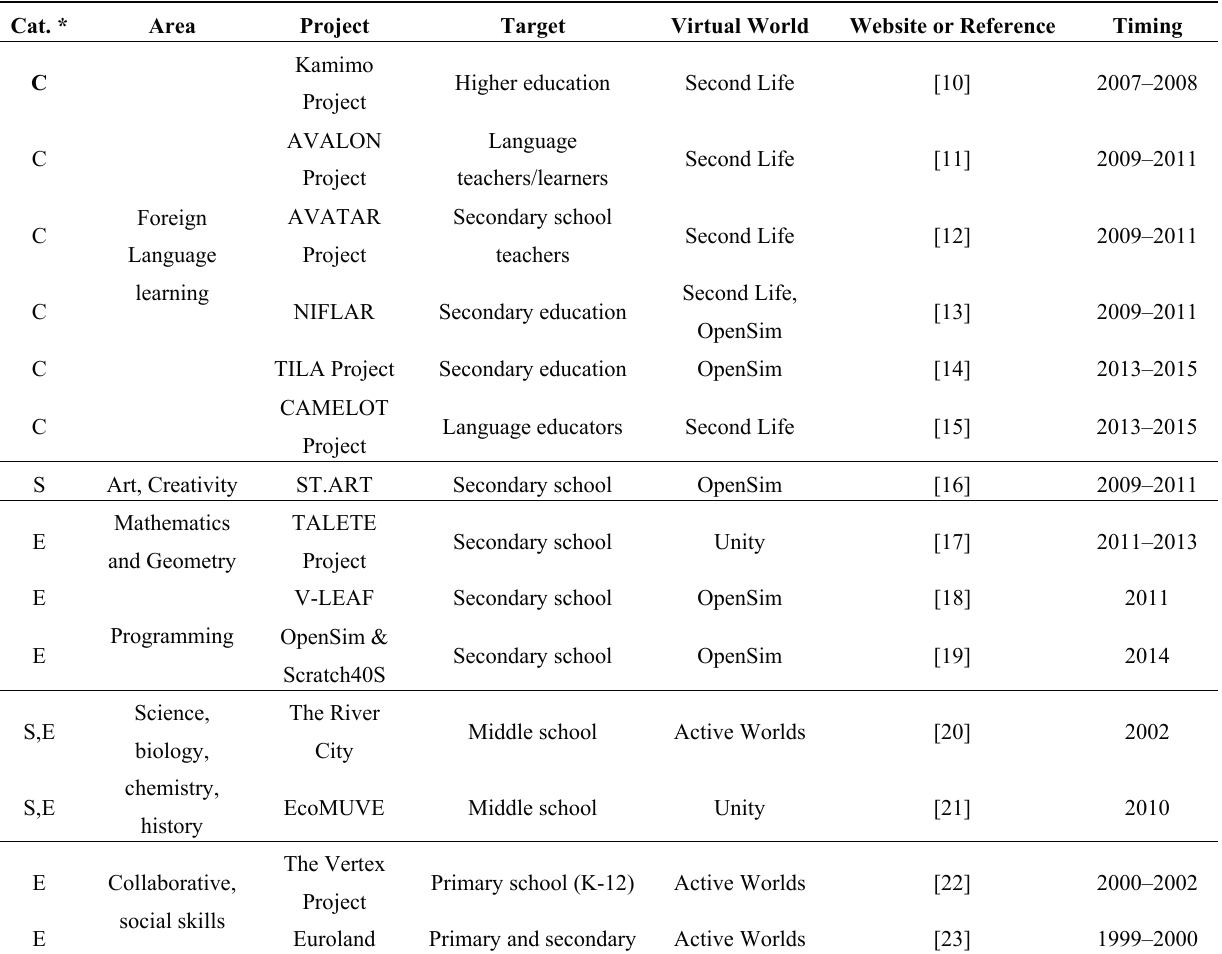
Table 1. Educational virtual